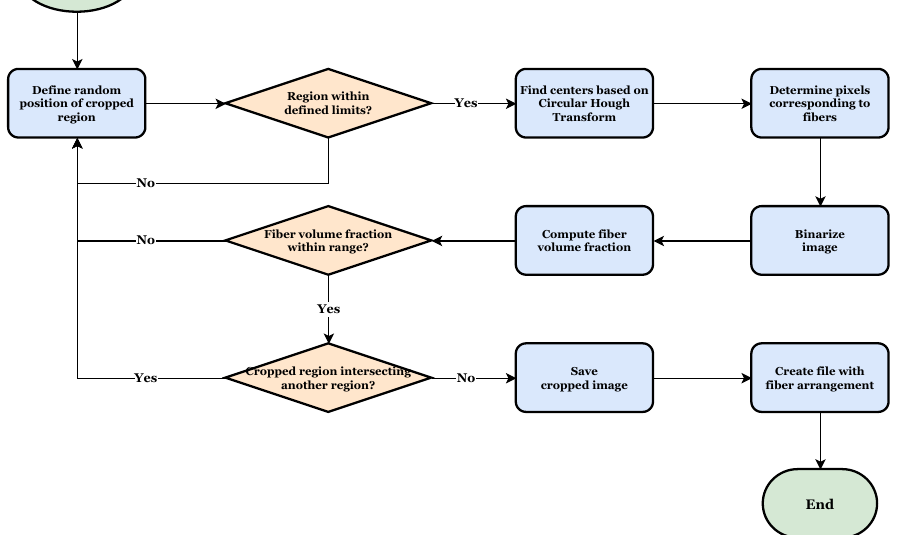
Figure 2. Proposed algorithm for cross-section micrograph processing.